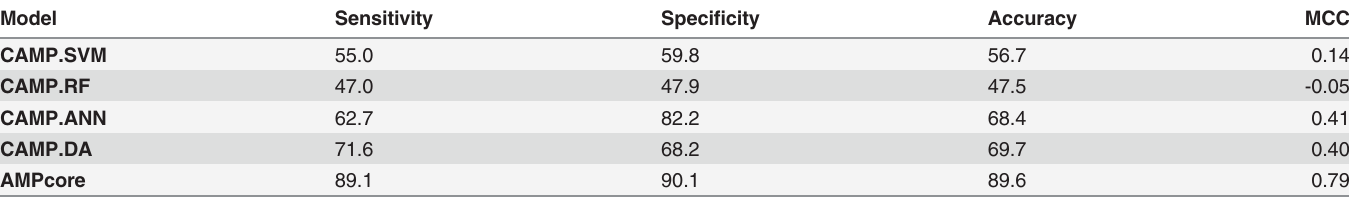
Table 3. Performance comparison with AMP prediction models on the comprehensive dataset of 798 AMP cores.